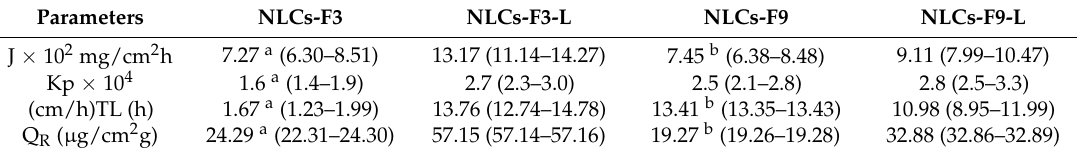
Table 5. Statistical differences between NLCs-F3 and NLCs-F3-L, and between NLCs-F9 and NLCs-F9-L. Results are reported as the median value and minimum-maximum range values ( n = 6). Letters represent significant differences ( p < 0.05) between a NLCs-F3 and NLCs-F3-L, and between b NLCs-F9 and NLCs-F9-L.